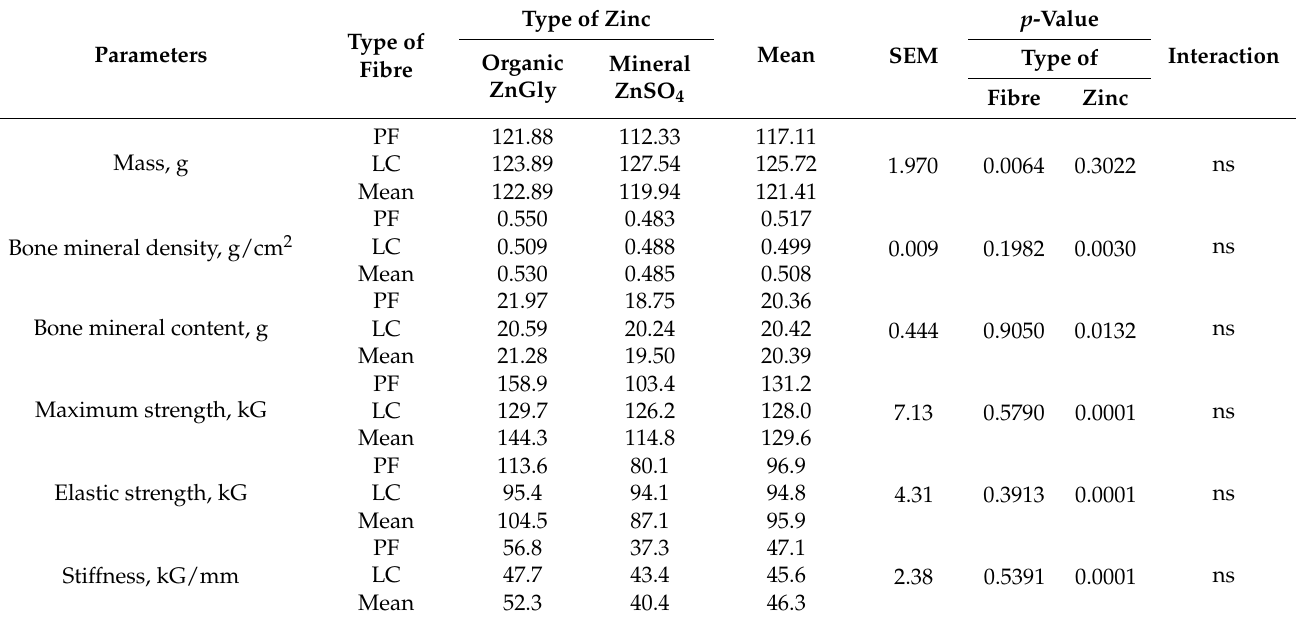
Table 4. Femur mass, mineral density, mineral content, maximum and elastic strength, and stiffness measured at the end of the study.